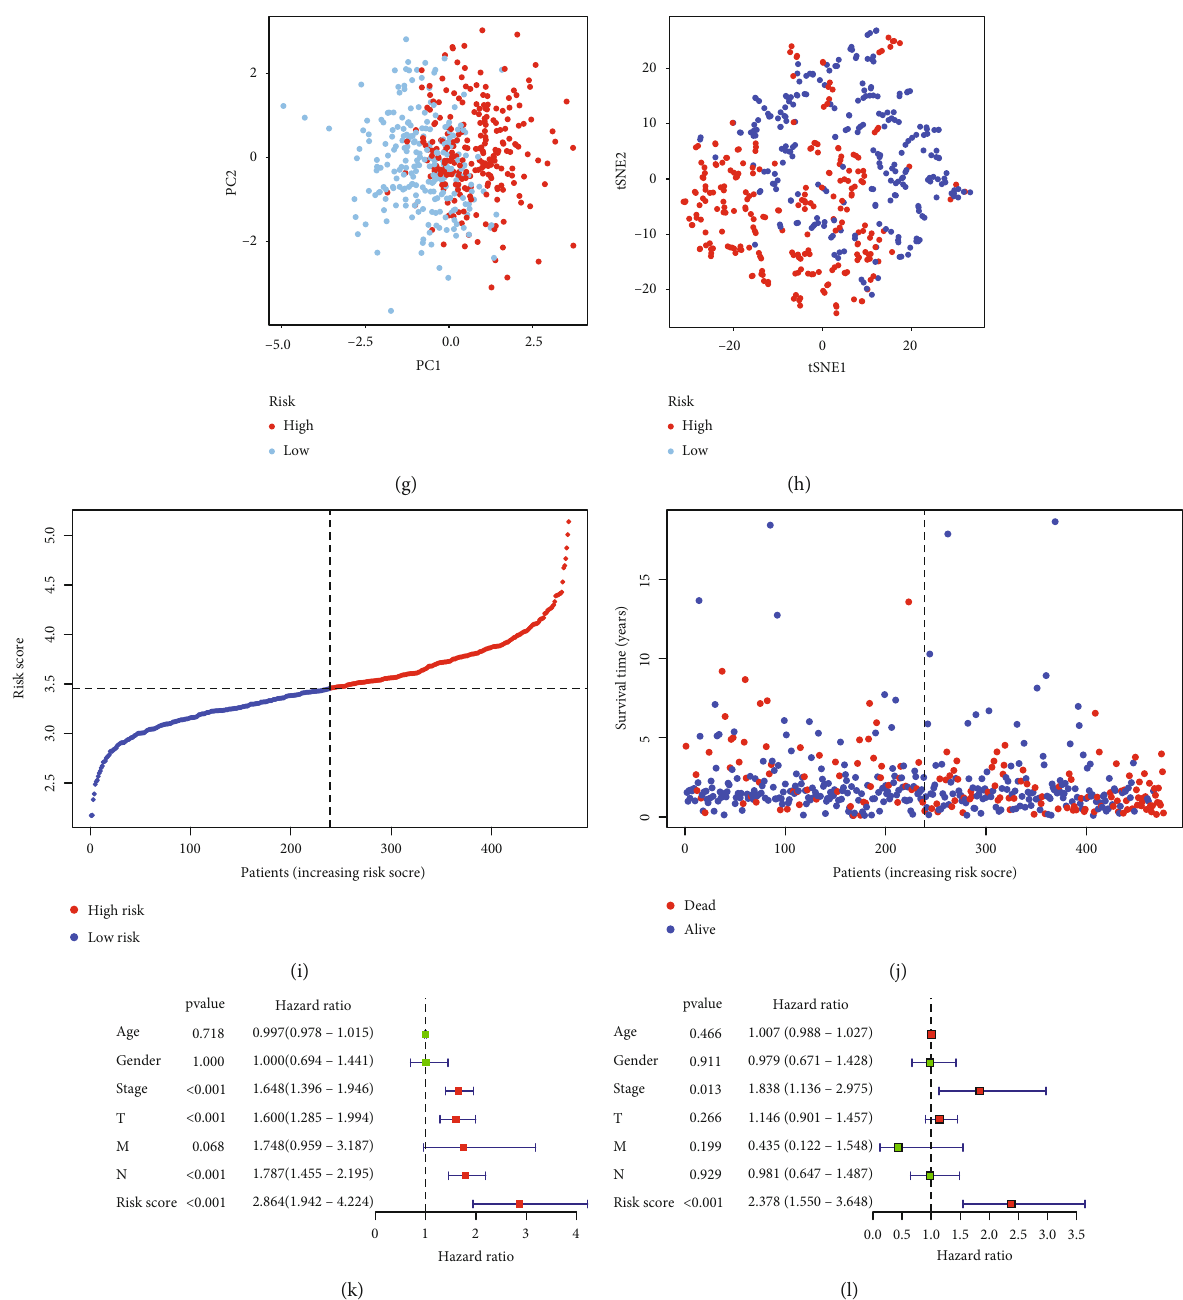
Figure 2: Construction of a prognostic PRG signature. (a) Forest plot showing nine prognosis-related PRGs. (b) Selection of penalty parameter in LASSO logistic regression. (c) Coe ffi cient of the signature genes when the penalty parameter was minimum. (d) Survival analysis of patients in TCGA data set. (e) ROC curve of TCGA data set. (f) ROC curve of risk score and clinical features. (g) PCA of TCGA data set. (h) t-SNE of TCGA data set. (i) Scatter plots showing the distribution of risk scores. (j) Scatter plots the relationship between risk score and survival time. (k) Forest plot of the univariate Cox analysis. (l) Forest plot of the multivariate Cox